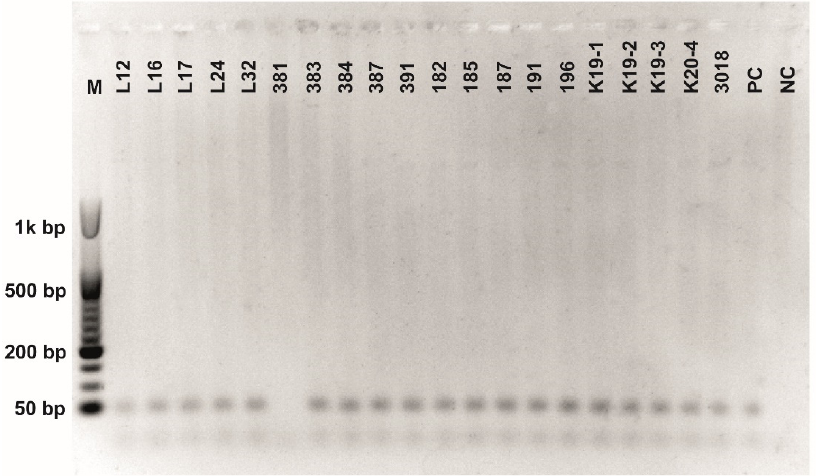
Figure A5. Class 2a bacteriocin gene belonging to the Clade 4 amplified using first primer pair (Table 3). O’RangeRuler TM 50 bp DNA Ladder was used as a molecular marker.